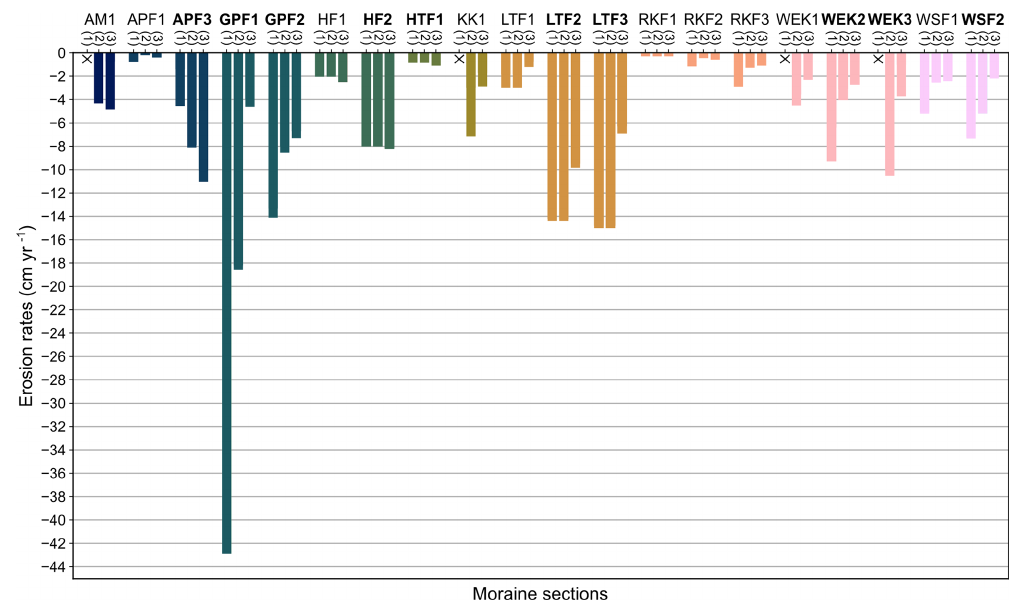
Figure 10. Erosion rates for 20 investigated moraine upper slopes for the three time periods (1) 1950s–1970s, (2) 1970s–2000s, and (3) 2000s–2018 (see Table 4 for specific DoDs). Moraine sections written in bold represent upper slopes with deeply incised gullies (colour map batlow10 from Crameri et al.,